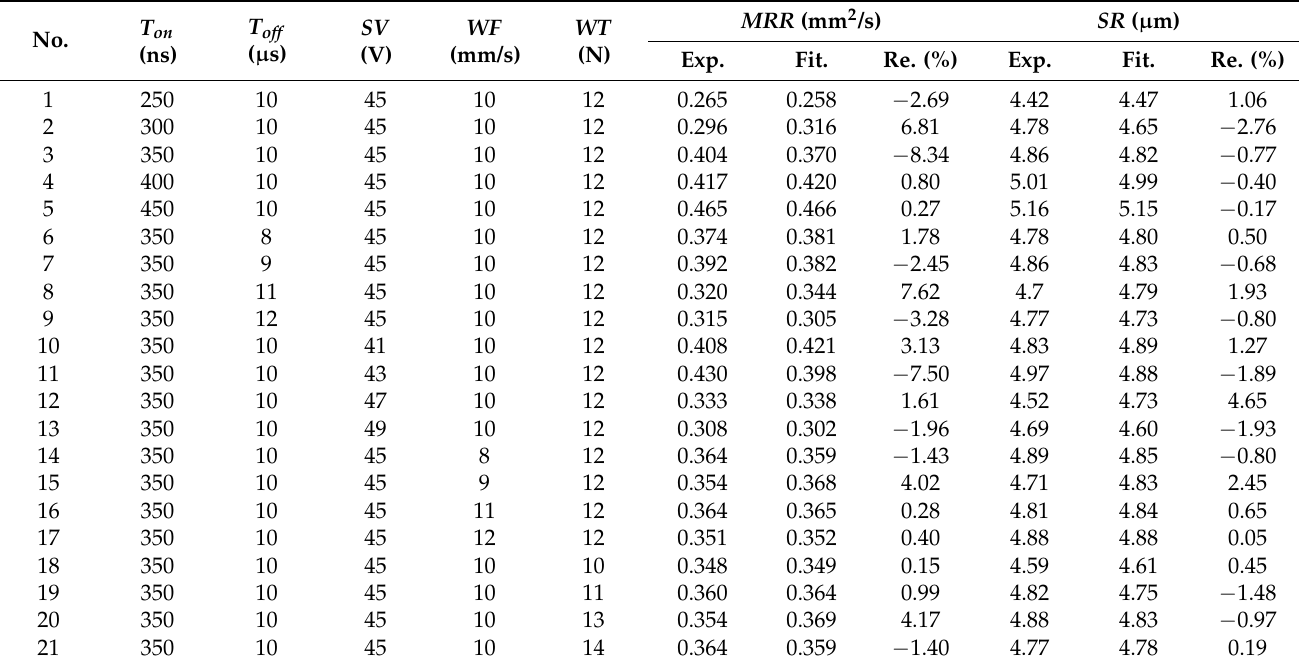
Table 6. The comparative results of experimental data and fitting